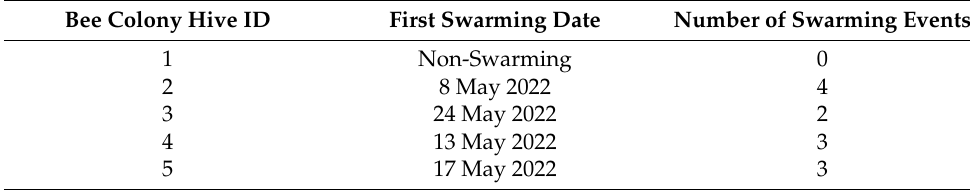
Table 3. Swarming date in the different hives of the